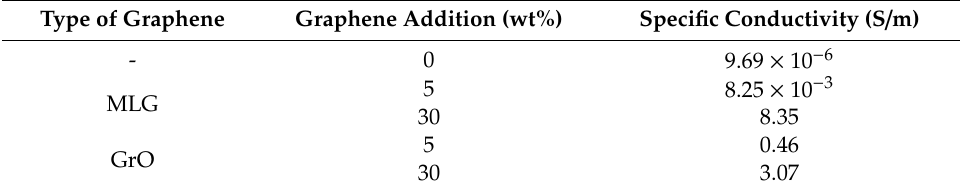
Table 1. Electrical conductivity of Si 3 N 4 -based